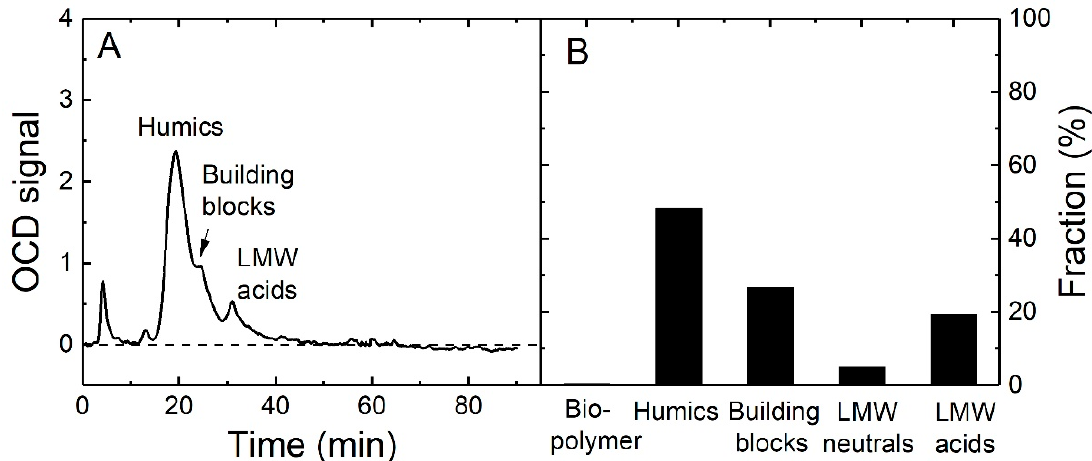
Figure 7. ( A ) Liquid chromatography–organic carbon detection (LC-OCD) signal of groundwater sample 1 as a function of time; ( B ) organic matter fraction in groundwater sample 1 (from Eslalei Lodge, water quality as shown in Table 4).